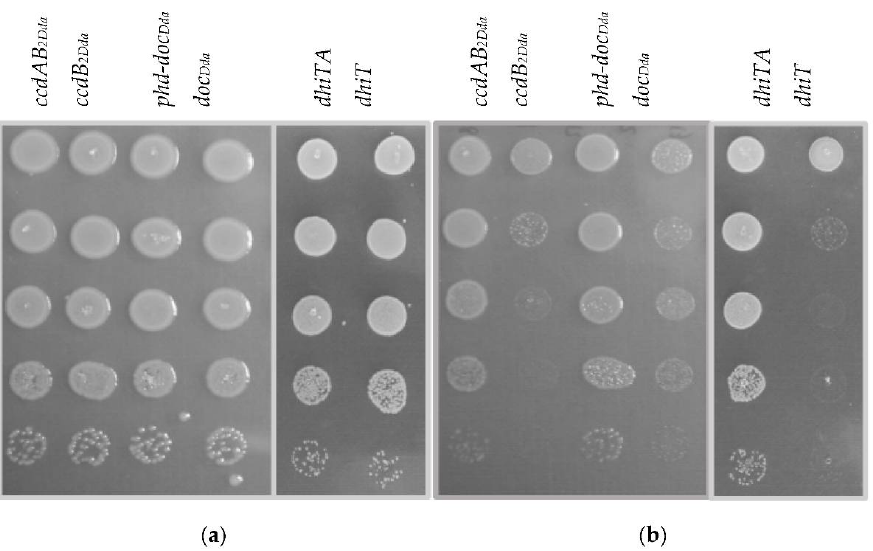
Figure 4. Effect of the putative toxins and toxin-antitoxin complex overexpression on growth of D. dadantii 3937. D. dadantii 3937 cells, harbouring derivatives of pBAD24 encoding toxin or antitoxin-toxin genes, under control of the P BAD promoter, were grown to OD 600 of 0.1–0.15. Each culture was serially diluted, and 15 µL drops of serial dilutions from 1 (top) to 10 −5 (bottom), were subsequently spotted onto different plates with ( a ) 0.2% D-glucose or ( b ) 0.2% L-arabinose.